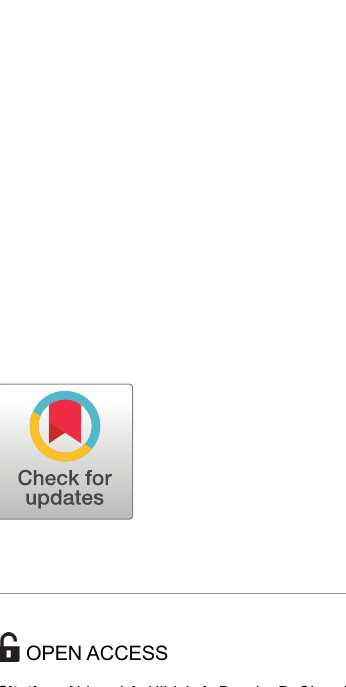
figshare.12575978.The word embeddings